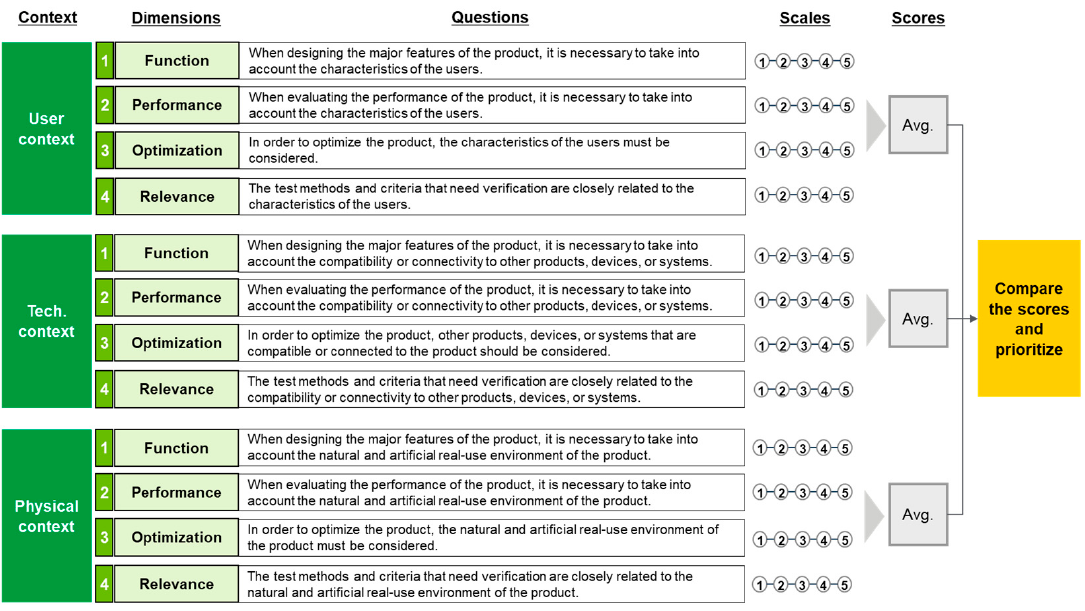
Figure 5. The Method for Prioritization.